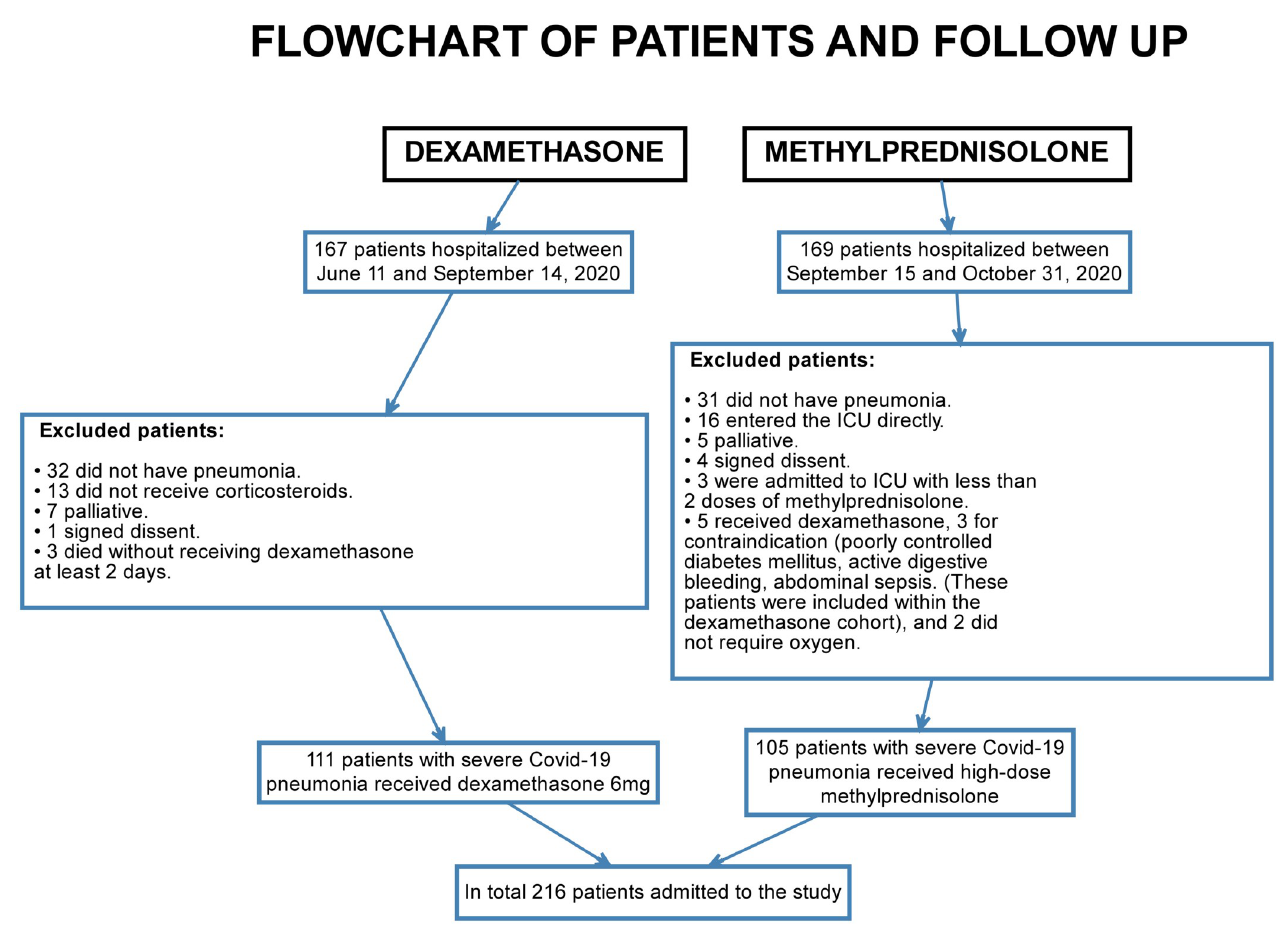
Fig 1. Flowchart of patients and follow